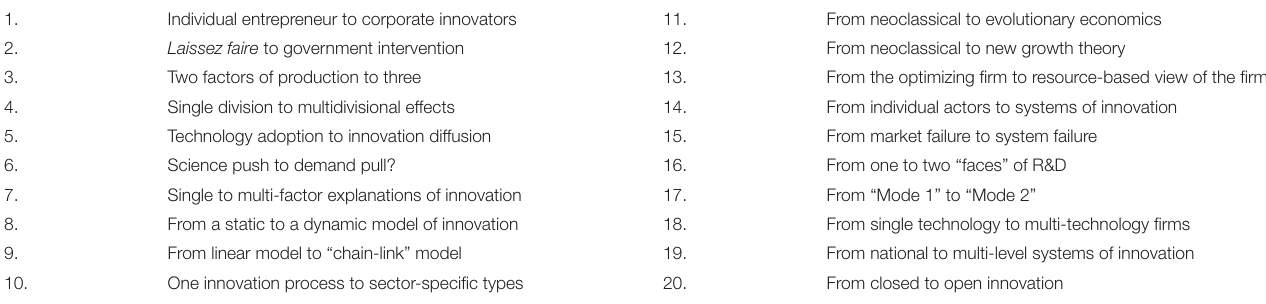
TABLE 1 | Evolution of science